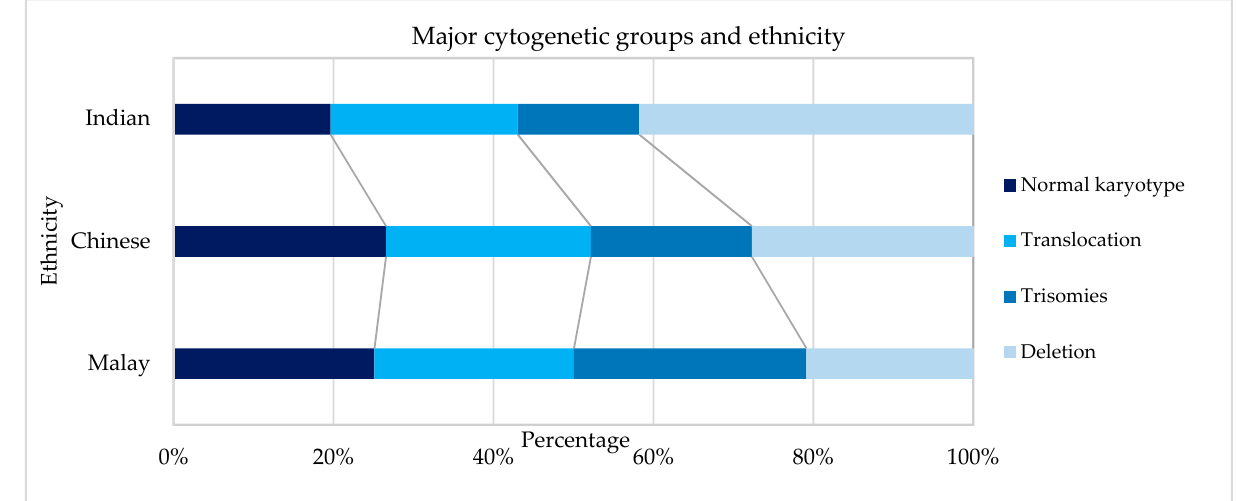
Figure 3. Cytogenetic profiles based on ethnicity.